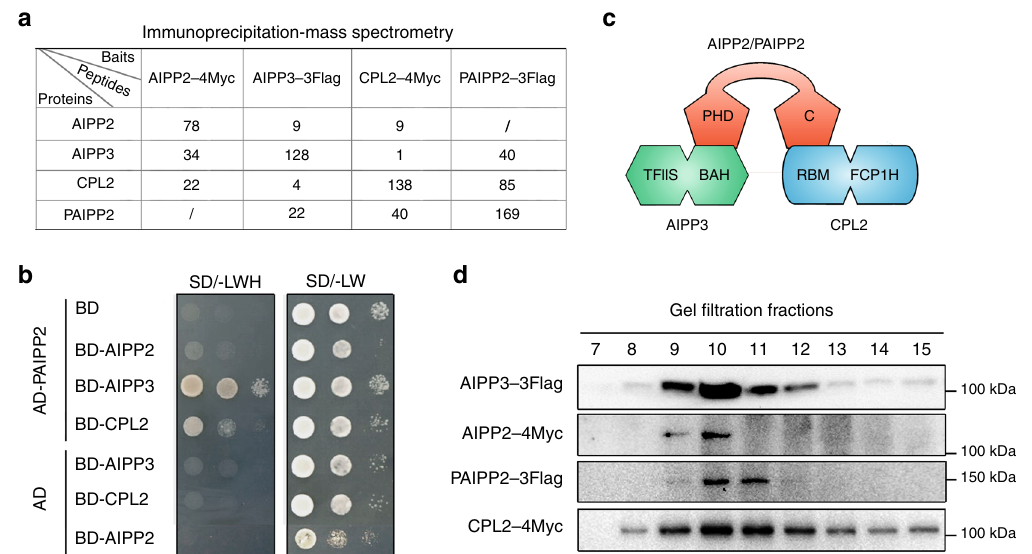
Fig. 1 The BAH protein AIPP3 associates with PHD proteins and CPL2 to form a protein complex. a Mass spectrometry analysis of epitope-tagged AIPP3 , AIPP2 , PAIPP2 , and CPL2 transgenic plants. b Y2H results showing the reciprocal interactions within the tested proteins. c A diagram showing the interaction network within AIPP3, AIPP2, PAIPP2, and CPL2. d Immunoblotting results of gel fi ltration assays. One of three independent experiments was